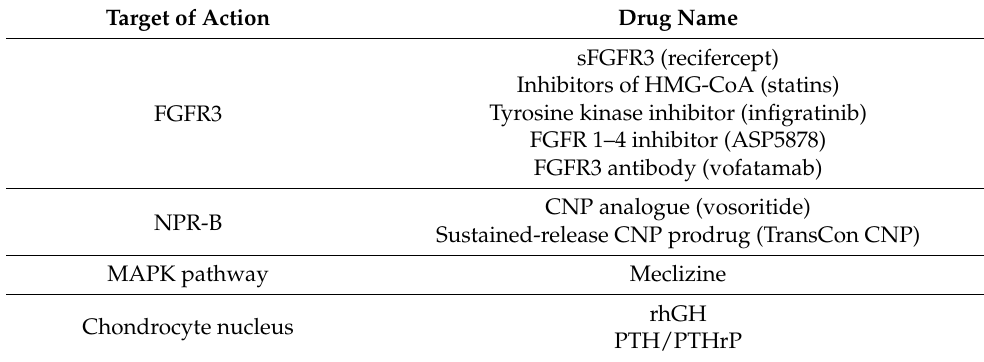
Table 1. Classification of drugs according to the target of action.